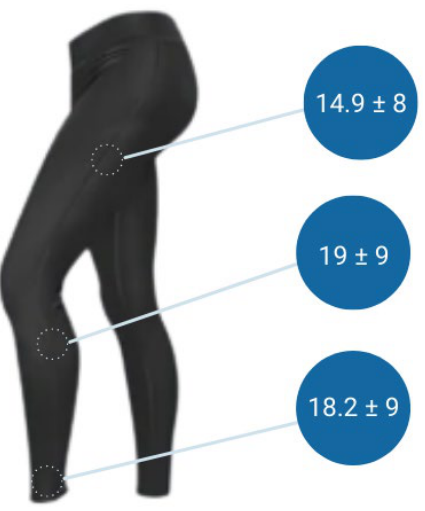
Figure 2. Average applied pressure ( ± SD) in mmHg reported at the thigh, calf and ankle for compression tights used in included ‘during recovery’ studies. Note: average calculated from 16 studies which reported ‘in vivo’ applied pressure at the time of testing.